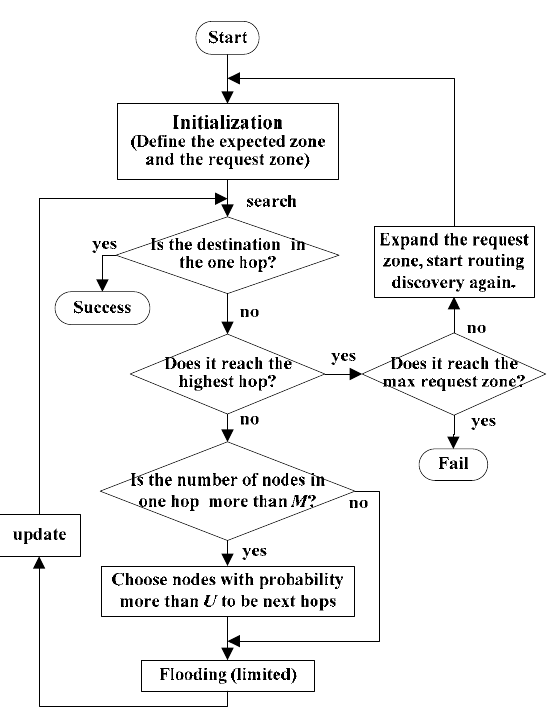
Fig. 6. The flow chart of the proposed G-LAR routing